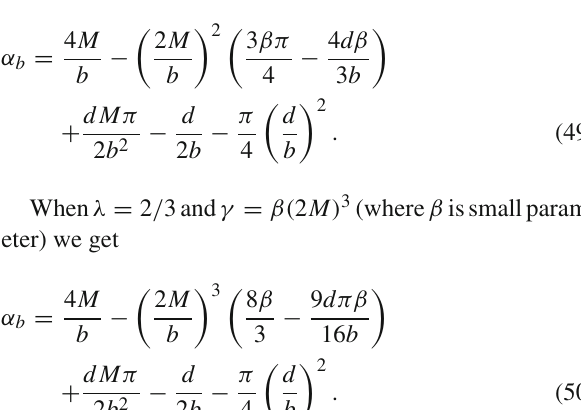
When λ = 1 and γ = β( 2 M ) 2 (where β is small